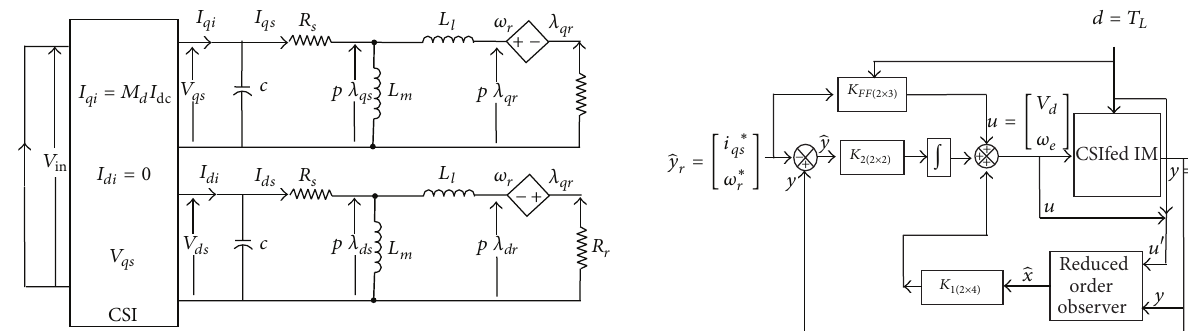
Figure 7: Combined feed forward and integral feedback